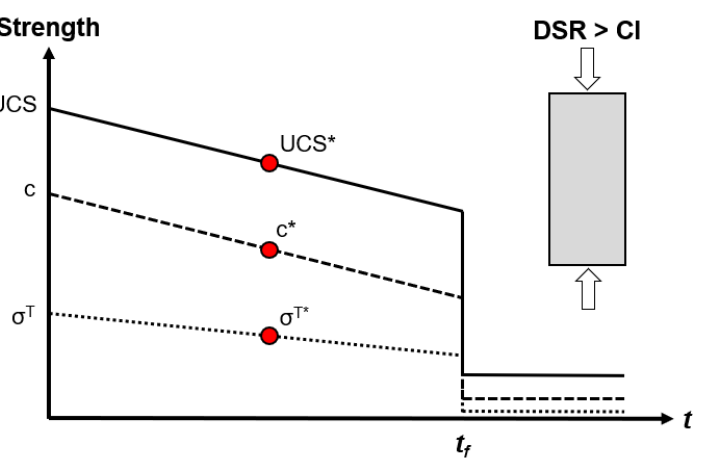
Figure 5. Schematic representation of the LTS model and the effect on the respective strength parameters when a sample is subjected to an applied constant load greater than its CI threshold. Note that friction angle has been omitted as it is assumed constant until failure. Values after tf are residual (post-yield), * denotes the change over time.